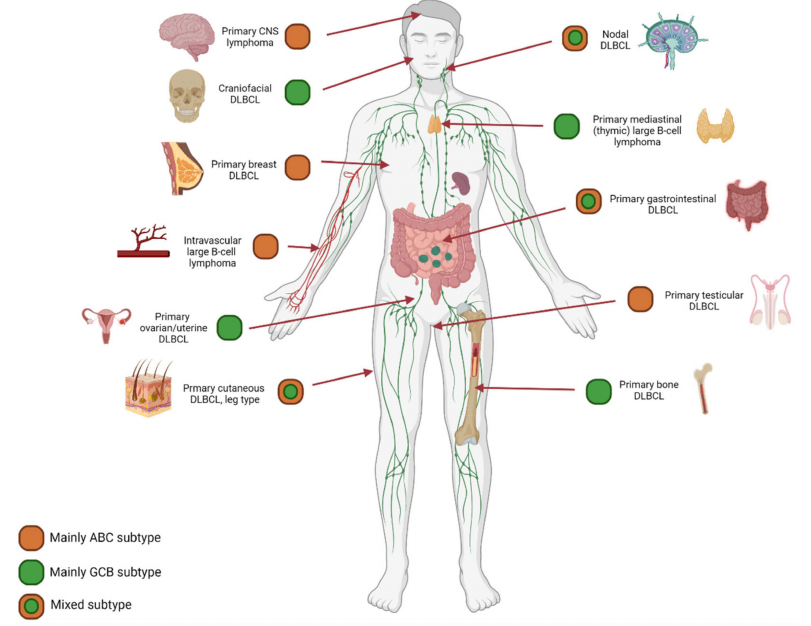
Figure 5. COO subtype: Anatomical localization matters. The results of diverse studies using GEP or Hans classification for COO determination demonstrated an evident association between anatomical preferred localization and COO subtype. For example, primary central nervous system lymphoma, primary testicular lymphoma, and intravascular large B-cell lymphoma harbor predominantly an ABC subtype. In contrast, we recently demonstrated a GCB subtype for primary bone DLBCL, that could be specified even further to unique cellular phenotypes [67]. This concept calls for additional investigation of well-annotated homogeneous cohorts of preferred localization DLBCL, including in-depth molecular